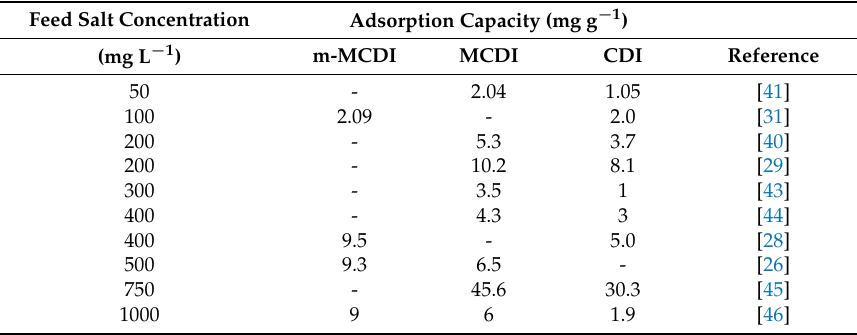
Table 3. A comparison of salt adsorption capacities from parallel studies of m-MCDI or MCDI versus Capacitive Deionisation (CDI).